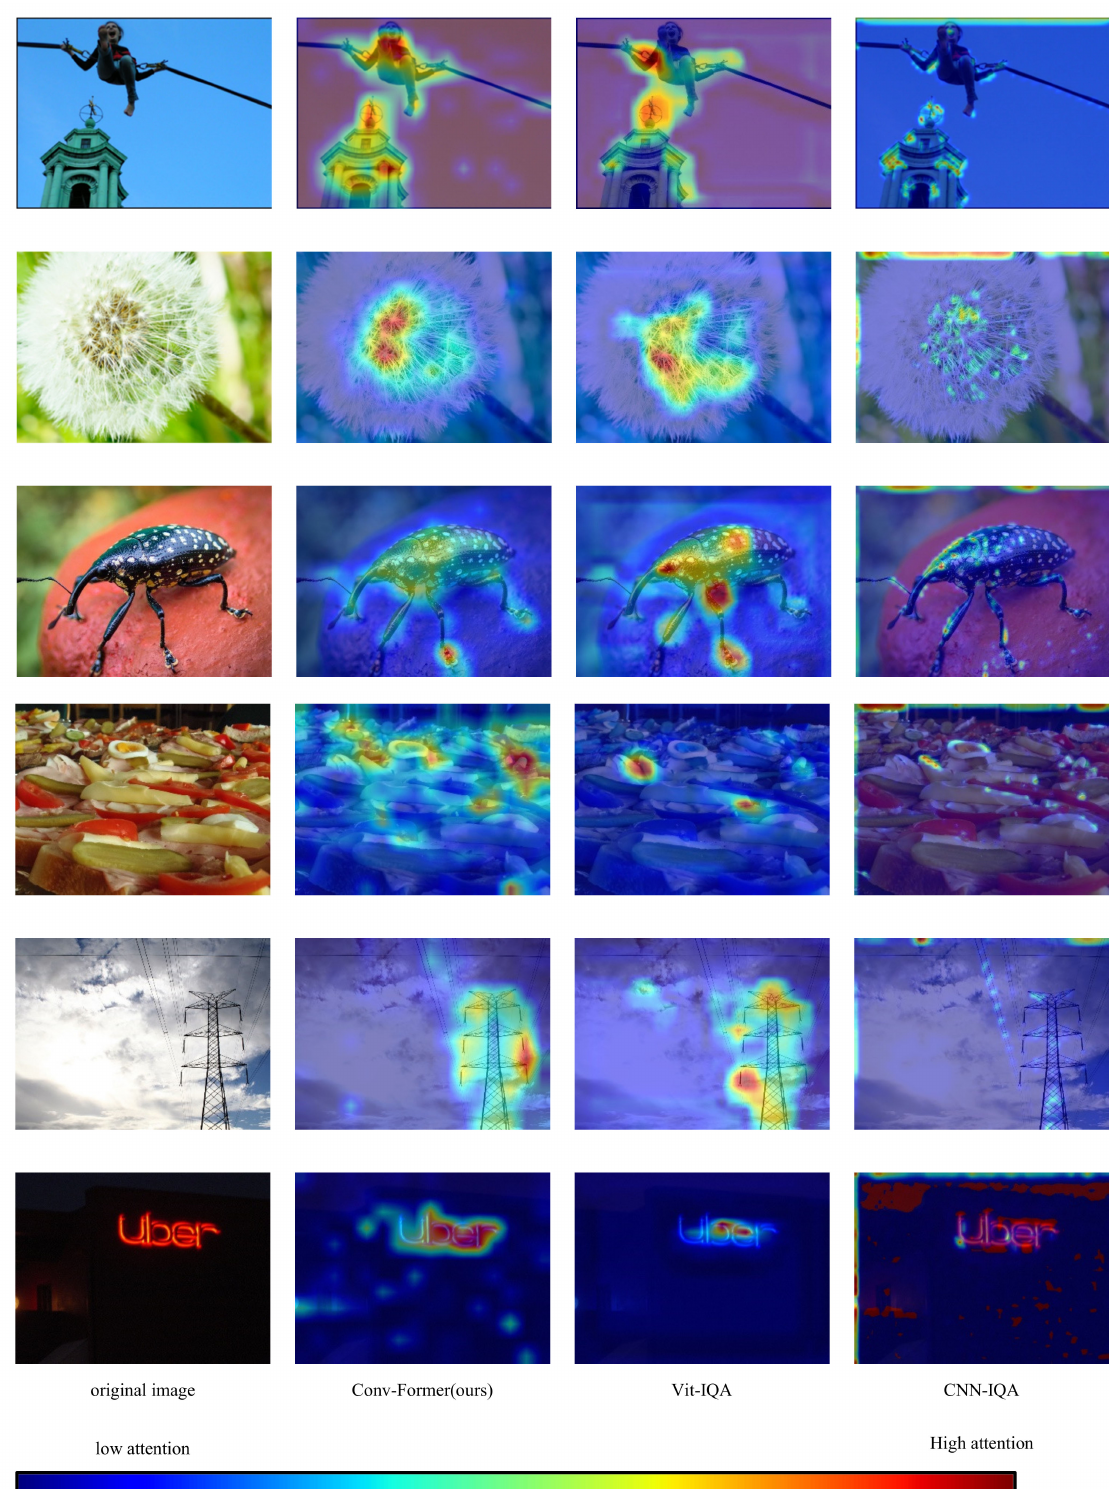
Figure 13. Comparison of attention maps for three different architectures of neural networks. All attentions are normalized in the range 0 to 1. The red areas mean the higher attention values, and the blue areas mean the lower attention values. The visual sensitive areas of our approach are more